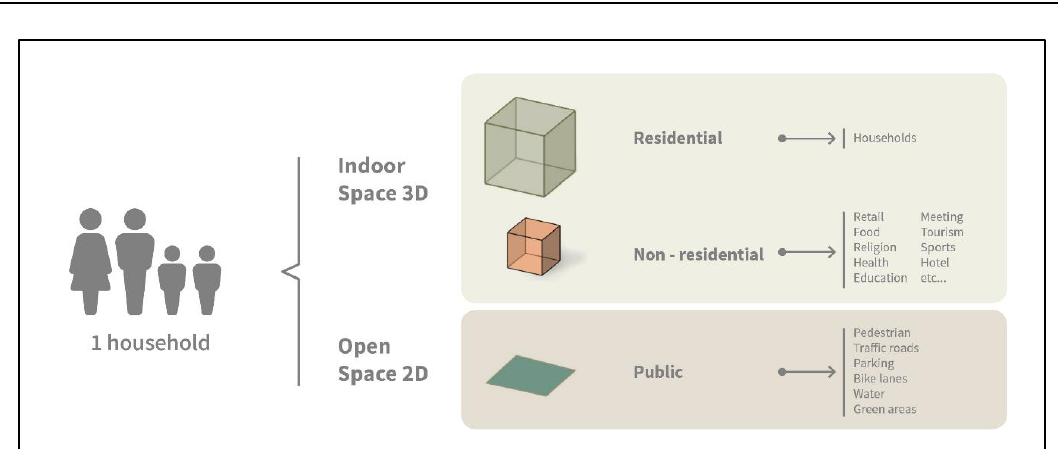
Figure 15. Overview of the two space calculation approaches: for 3D indoor spaces and 2D open spaces.